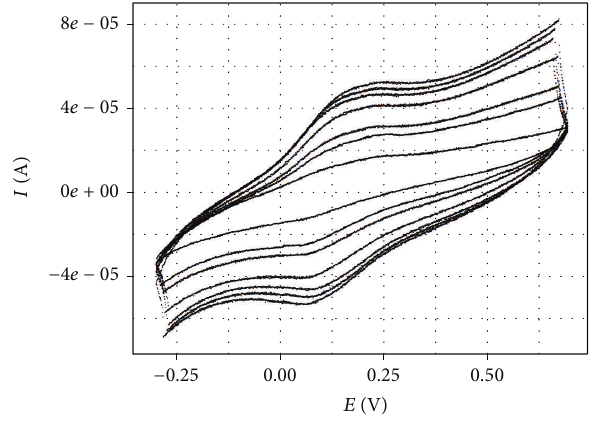
Figure 2: Cyclic voltammogram of Mb/PMMA- b -PDMAEMA in phosphate buffer at different scan rates (20–500 mV/s).